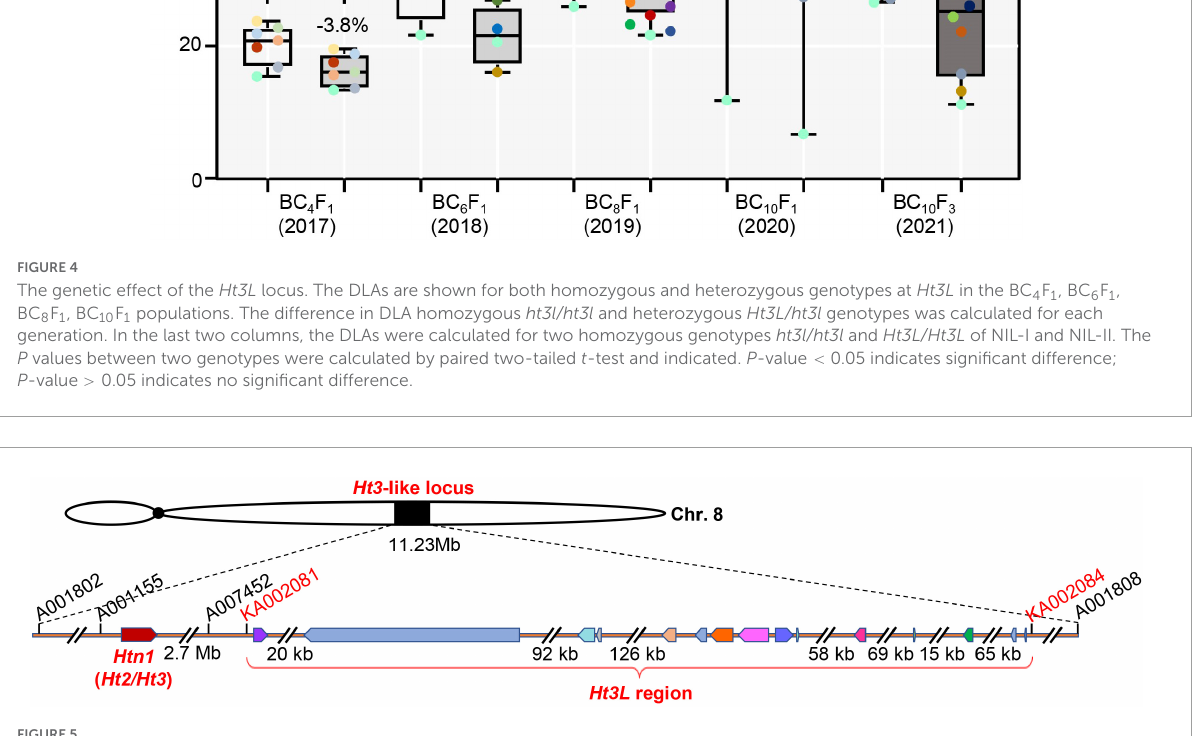
FIGURE5 The Ht3L locus is independent from Htn1 . The mapped Ht3L region encompassing 15 annotated genes, which was located 2.7-Mb to the right of Htn1